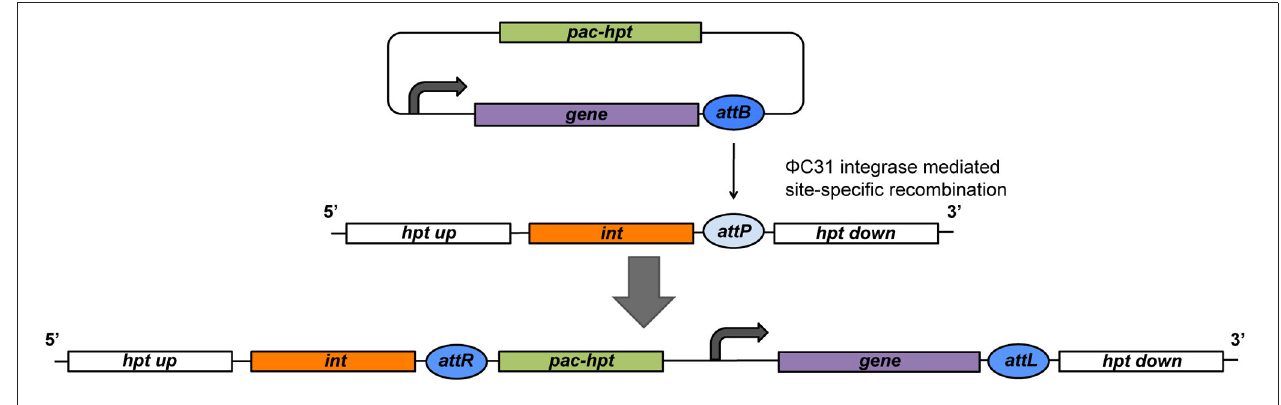
FIGURE 1 | Schematic of a site-specific recombination event at the engineered (cid:2) hpt locus of the Methanosarcina chromosome. The (cid:3) C31 integrase ( int ) is constitutively expressed at the (cid:2) hpt locus that also harbors a (cid:3) C31 attachment site ( attB in this figure). The integration